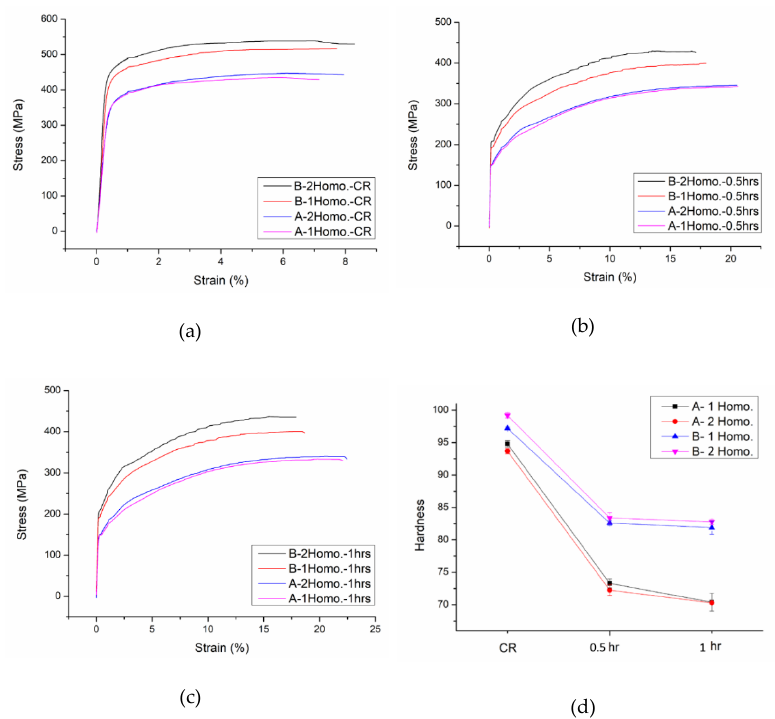
Figure 8. The mechanical properties of Alloy A (0Mn) and Alloy B (0.8Mn): ( a ) tensile curves after cold-rolled; ( b ) tensile curves after 400 ◦ C annealing for 0.5 h; ( c ) tensile curves after 400 ◦ C annealing for 1 h; ( d ) hardness curves.